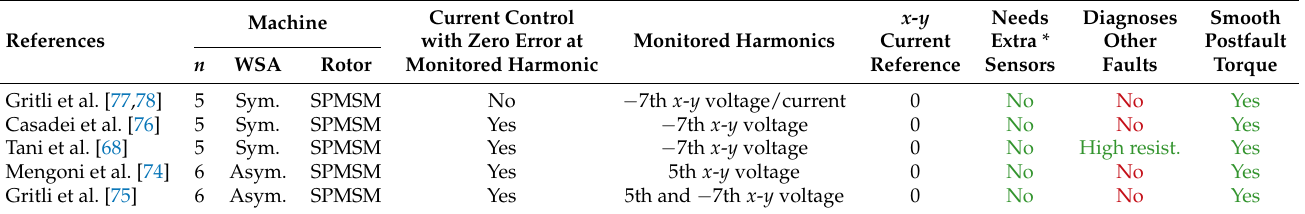
Table 23. Methods for detecting magnet demagnetization (Section 11.2) in multiphase applications in the